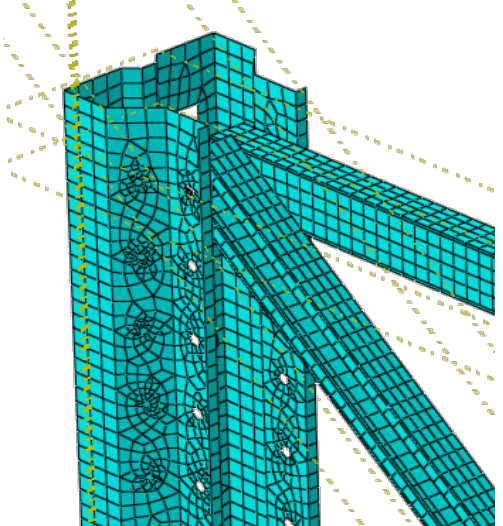
Fig. 7. Details of joint of frame and meshing of column section without spacer bar [12].